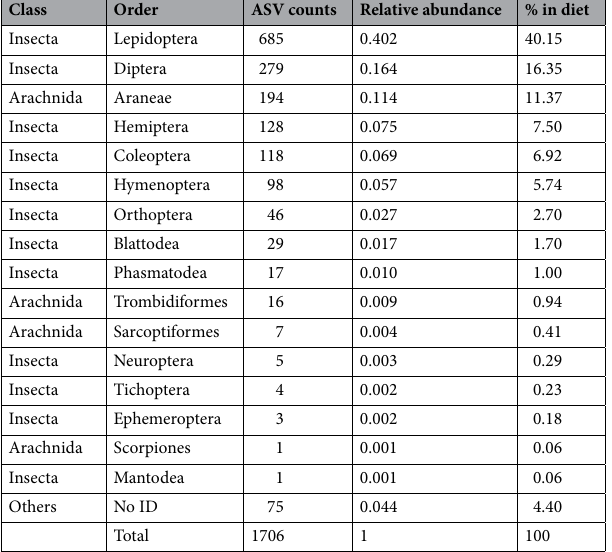
Table 2. Arthropod Amplicon Sequence Variants present in the scats of Colombian highland Woolly Monkeys ( Lagothrix lagotricha lugens ) at Cueva de los Guácharos National